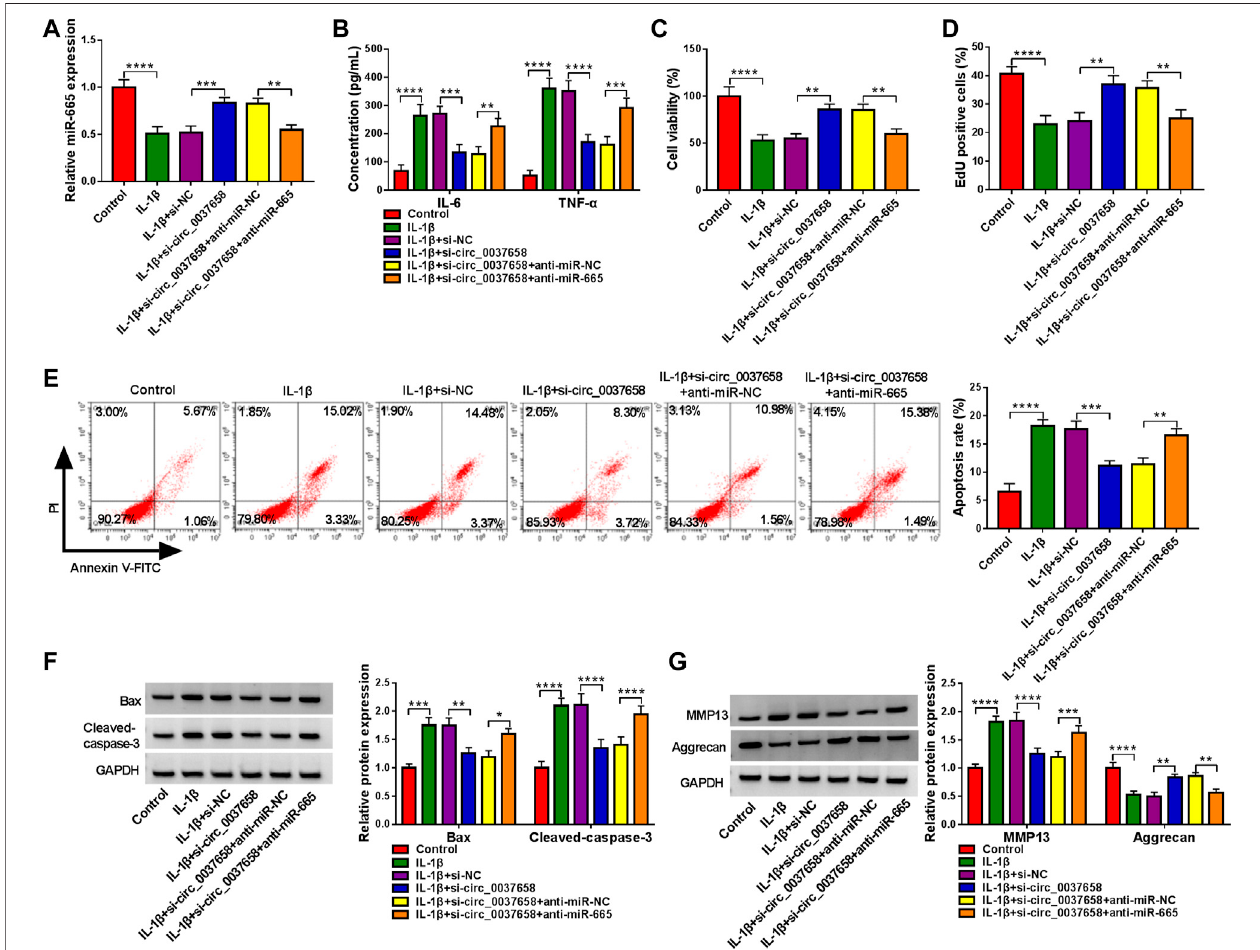
FIGURE 4 | Downregulation of miR-665 counteracted the effect of circ_0037658 on in fl ammation, proliferation, apoptosis, and ECM degradation in IL-1 β -treated chondrocytes. CHON-001 cells were treated with IL-1 β , IL-1 β +si-NC, IL-1 β +si-circ_0037658, IL-1 β +si-circ_0037658+miR-NC, IL-1 β +si-circ_0037658+miR-665, or without (Control). (A) miR-665 level was detected in treated CHON-001 cells using RT-qPCR assay. (B) ELISA was adopted for IL-6 and TNF- α level in treated CHON- 001 cells. (C,D) CCK-8 assay and EdU assay were applied to analyze cell proliferative ability in treated CHON-001 cells. (E) Cell apoptosis rate in treated CHON- 001 cells. (F,G) Western blot analysis was utilized for Bax, Cleaved-caspase-3, MMP13, and Aggrecan protein levels in each group, and GAPDH was used as a loading control.****or*** indicates p < 0.0001or p < 0.001whenIL-1 β group wascompared tothenegativecontrolgroup and **,***,or ****indicates p < 0.01, p < 0.001or p < 0.0001 when IL-1 β +si-circ_0037658 group was compared to the IL-1 β +si-NC group and **, ***, or **** indicates p < 0.01, p < 0.001 or p < 0.0001 when IL-1 β +si- circ_0037658+anti-miR-665 group was compared to the IL-1 β +si-circ_0037658+anti-miR-NC group. These results were presented as the mean ± (SD), n =